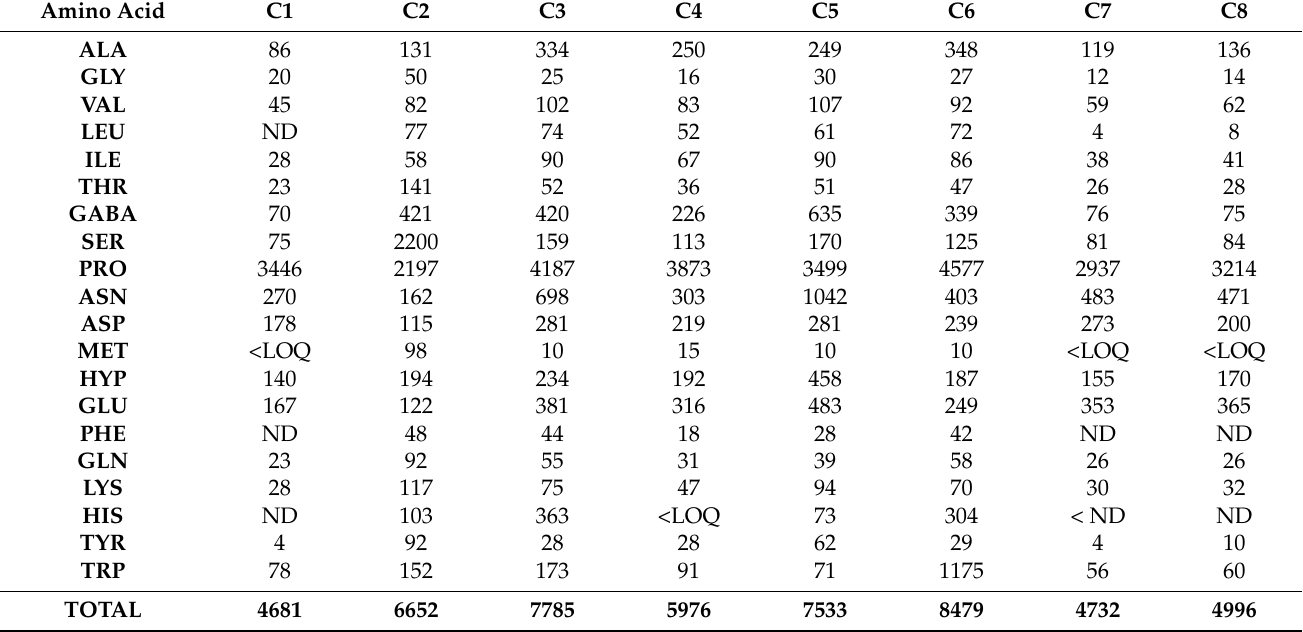
Table 6. Results (means of triplicate analyses (mg/kg; dry weight); %RSD < 15% in all cases) of the investigation of bee pollen samples from commercial origin